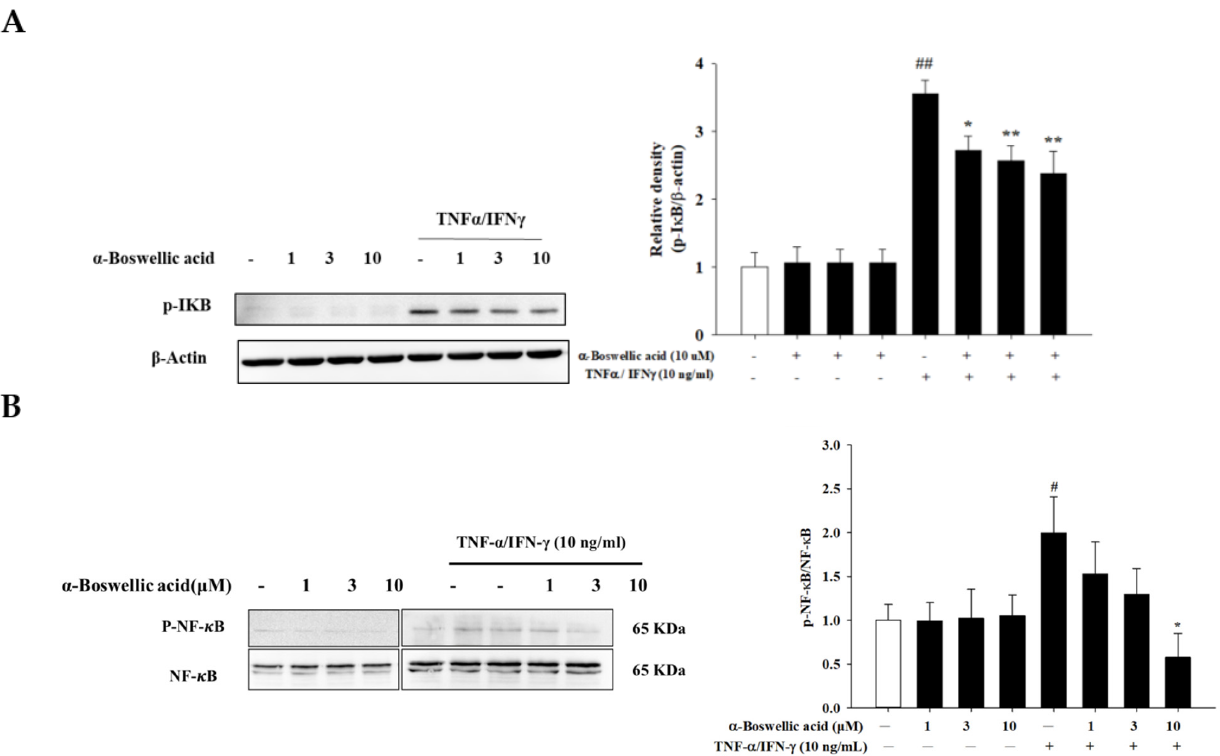
Figure 5. ( A , B ) Effects of α -boswellic acid on the degradation of I κ B- α and phosphorylation of NF- κ B/p65 protein in TNF- α /IFN- γ -induced HaCaT cells. HaCaT cells were pretreated with different concentrations of α -boswellic acid (1, 3, and 10 µ M) for 20 min, and then the cells were treated with TNF- α /IFN- γ for 30 min. Western blots were analyzed quantitatively. Values represent the mean ± SEM from three and four independent experiments. # p < 0.05 and ## p < 0.01 compared with the no-treatment condition; * p < 0.05 and ** p < 0.01 compared with the only TNF- α /IFN- γ treatment